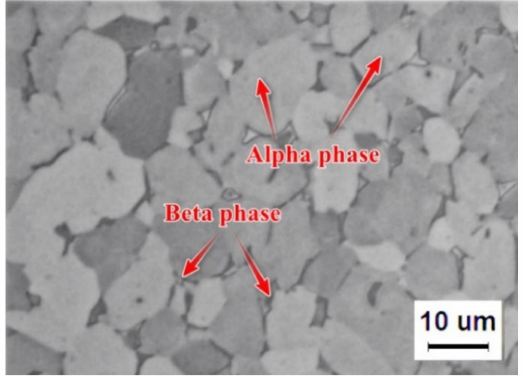
Figure 2. The initial microstructure of the received